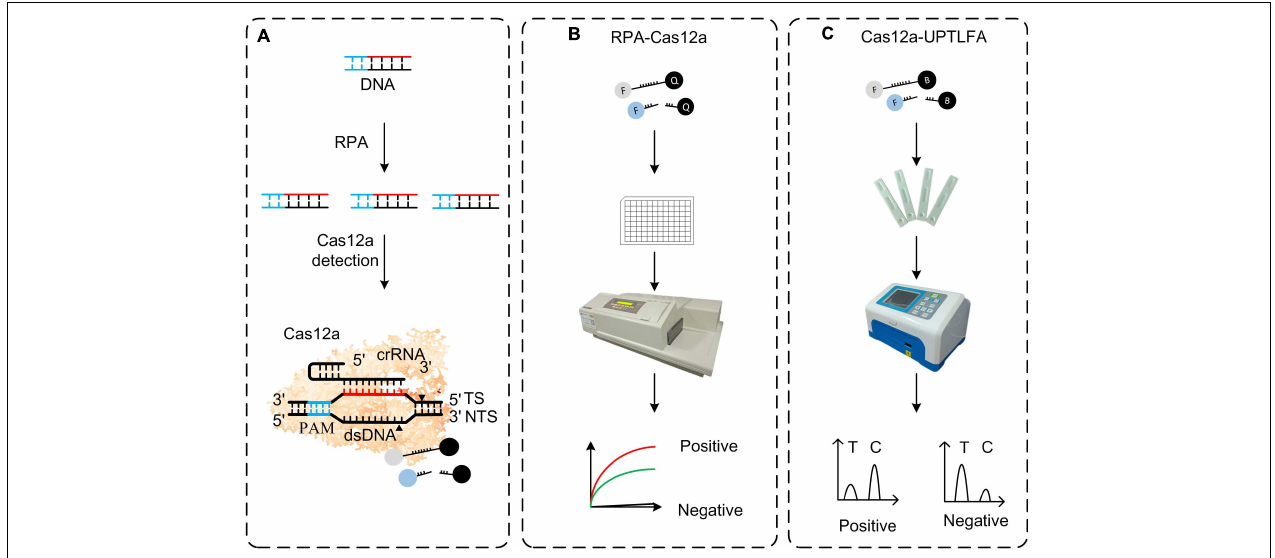
FIGURE 1 | Overview of RPA-Cas12a and Cas12a-UPTFLA platform. (A) Target genes were amplified by RPA prior to Cas12a detection. Upon recognition of their dsDNA targets, Cas12a nucleases were activated, and the reporters were then cleaved indiscriminately. (B) FAM-BHQ reporters were used in RPA-Cas12a detection by fluorescence read-out method using a microplate reader. A positive sample will exhibit rapid increase of fluorescence signals, while a negative sample will only produce background signal. (C) UPT lateral flow immunochromatographic assay was incorporated with RPA-Cas12a detection method described in panel (B) to be Cas12a-UPTFLA. This method adopted FAM-biotin, instead of FAM-BHQ, labeled ssDNA as the reporter, and results were obtained by scanning using an UPT biosensor. Cutoff value was set according to the T/C values of the negative controls to designate the positive or negative results. RPA, recombinase polymerase amplification; UPT, up-converting phosphor